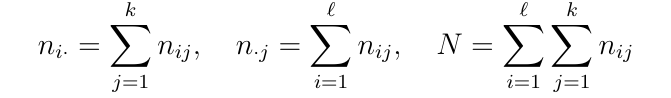
Table 3. Number of values of each C